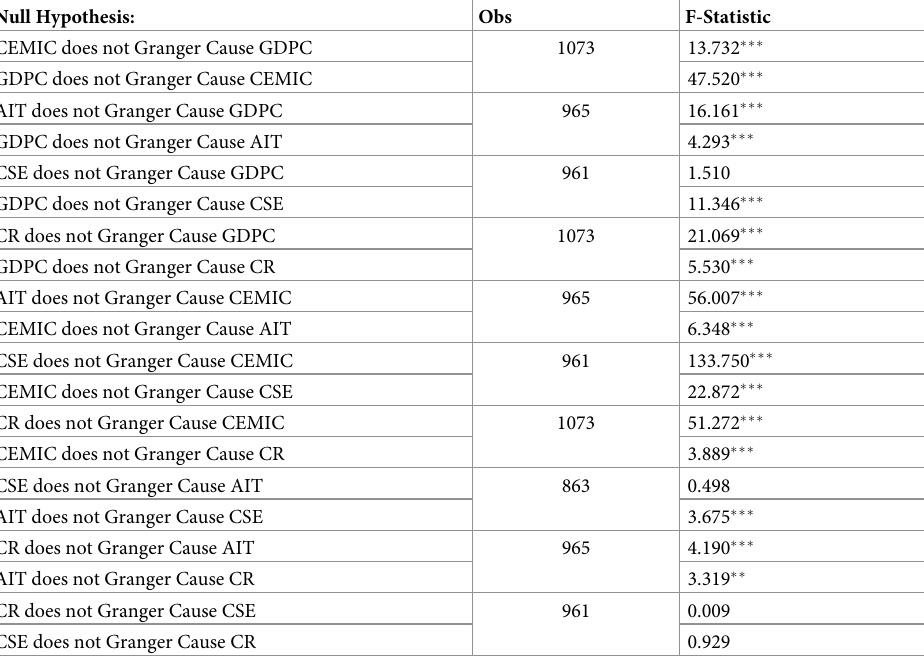
Table 12. Pairwise Granger causality tests.